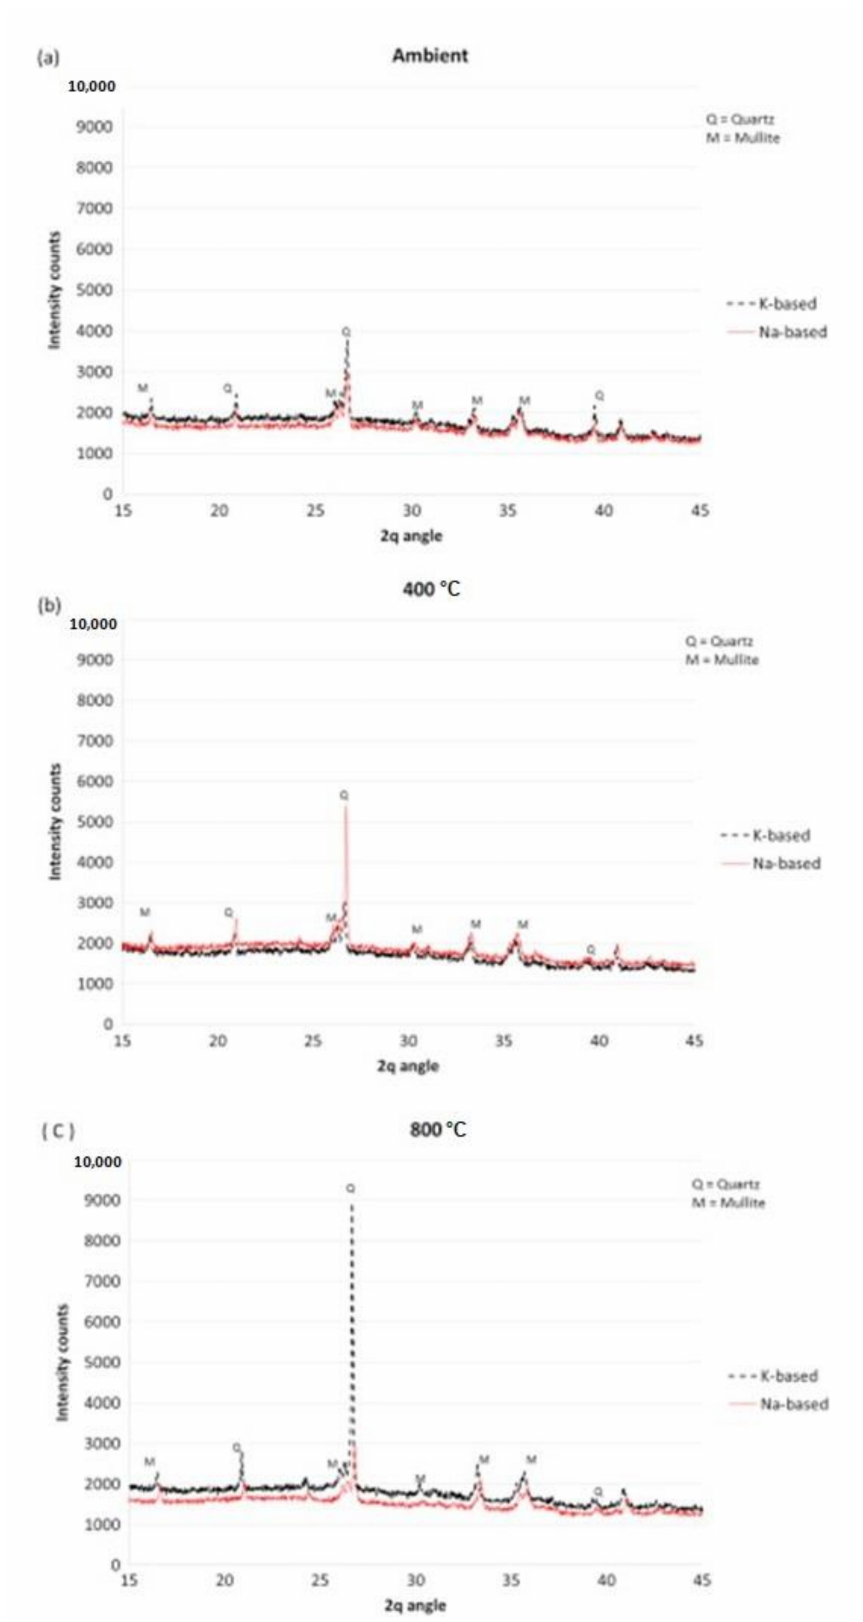
Figure 5. XRD analysis of Na- and K-based fly ash geopolymer ( a ) ambient, ( b ) at 400 ◦ C and ( c ) at 800 ◦ C temperatures